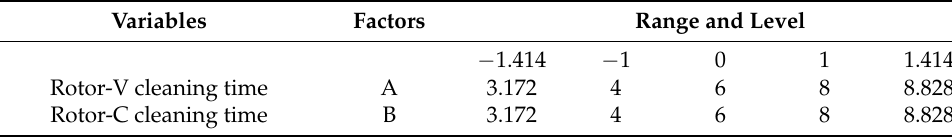
Table 2. Experimental range and the level of the independent variables.